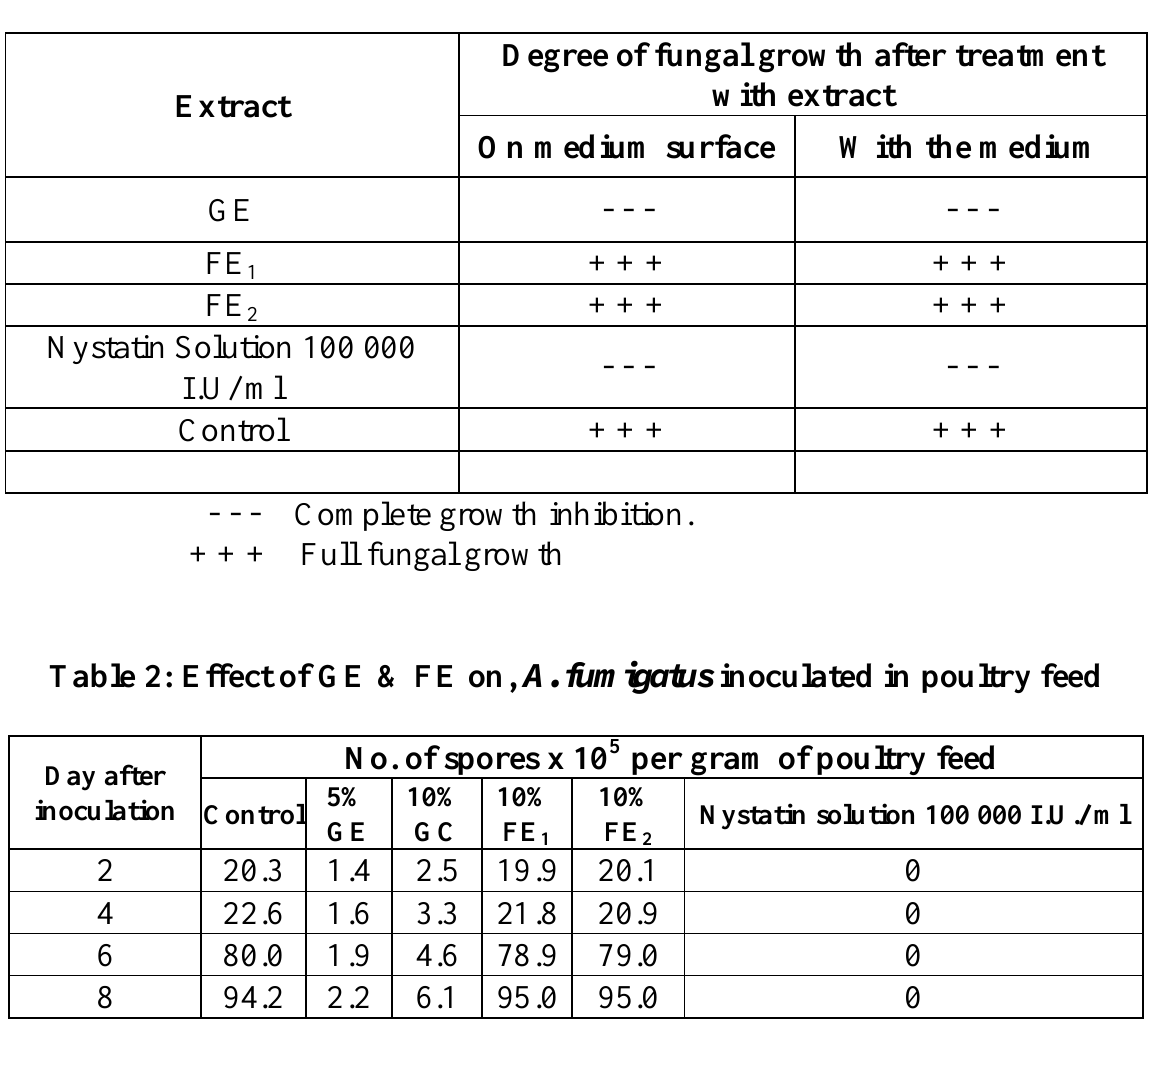
Table 1: Effect of GE & FE on A . fumigatus